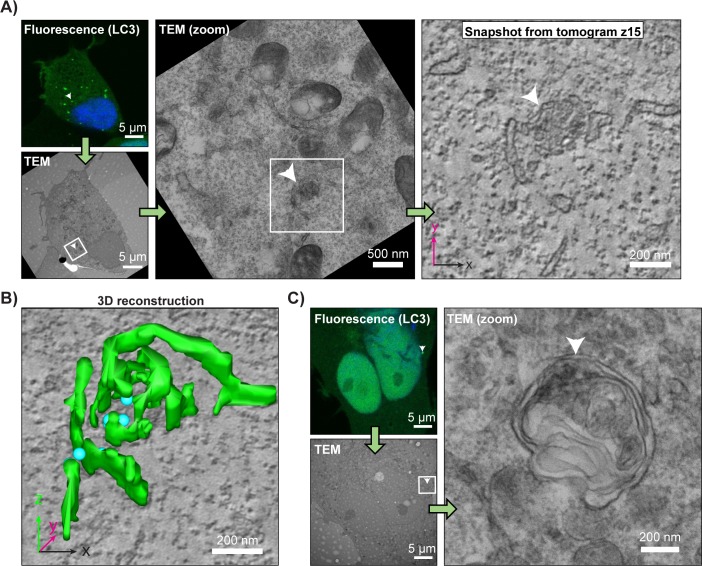
Pre-autophagosomal membranes fail to coalesce in TMEM41BKO cells.CLEM of HEK293T TMEM41BKO (A and B) and wild-type HEK293T cells (C) expressing tfLC3 that were grown under basal conditions (no drug treatment). Analysis workflow is indicated by green arrows. White arrowheads indicate a representative structure of interest. White boxes demarcate zoomed areas in subsequent images. Blue indicates Hoechst 33342. Panel A includes a sample tomogram used to make the three-dimensional reconstruction (in B) of the membranous structures found in the GFP-positive region. Green indicates membrane sheets and tubes; cyan indicates membrane vesicles. See Materials and methods for further CLEM analysis details. Related to S6 Fig. CLEM, correlative light and electron microscopy; GFP, green fluorescent protein; HEK, human embryonic kidney; LC3, microtubule-associated protein 1 light chain 3B; TEM, transmission electron microscopy; tf, tandem-fluorescent.